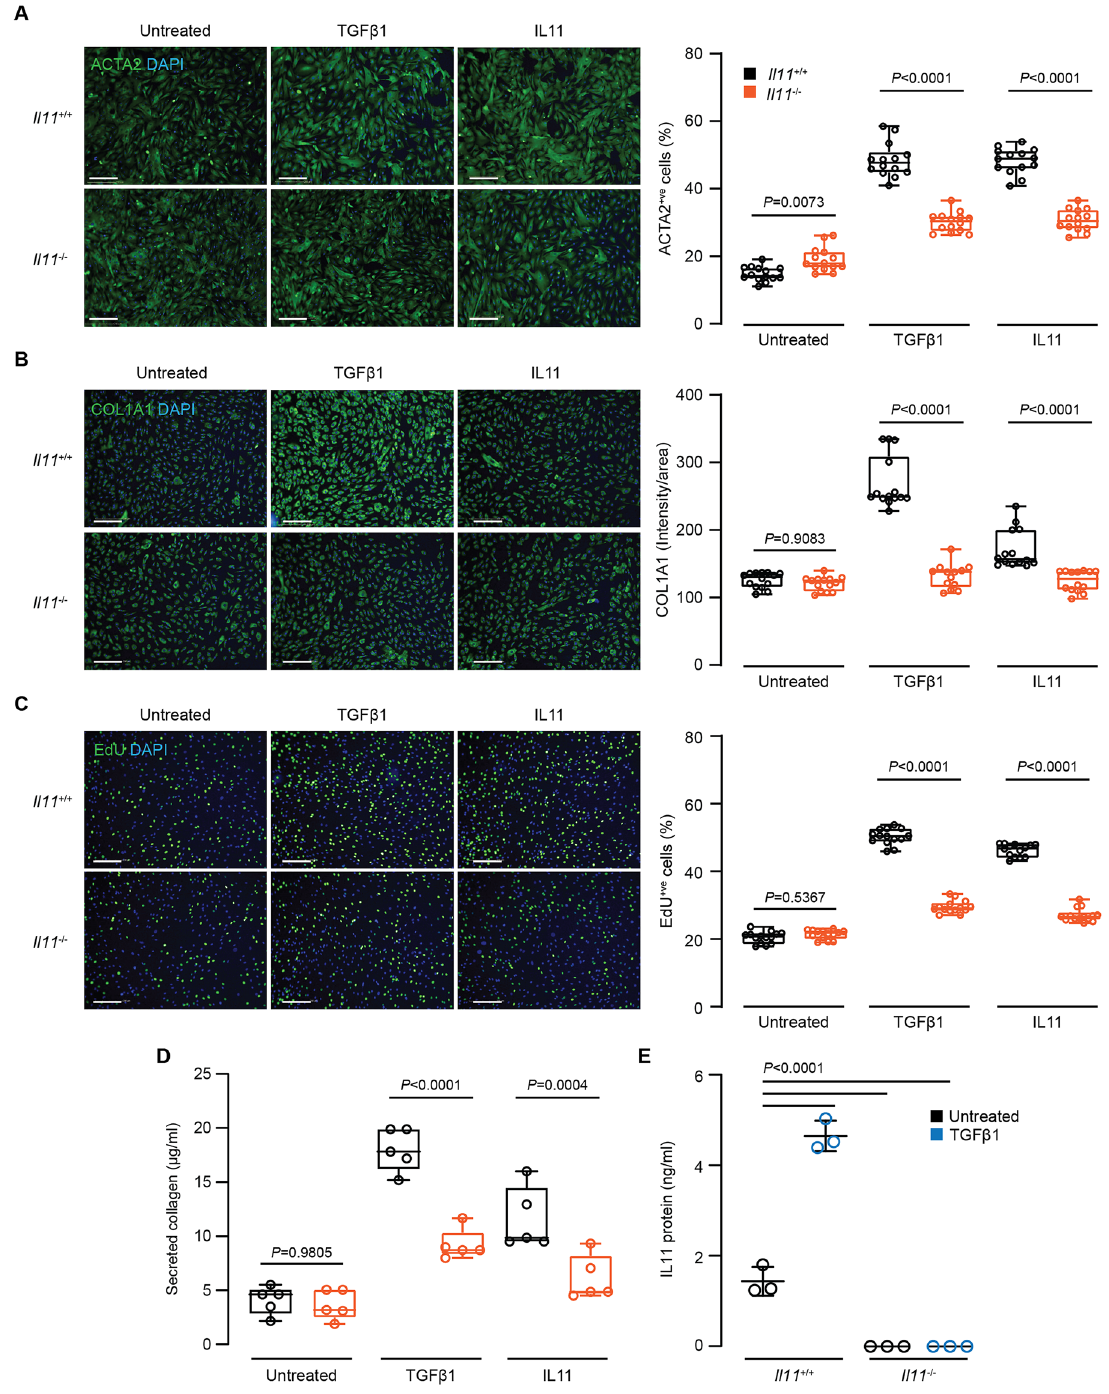
Figure 3. Reduced activation of primary lung fibroblasts from Il11 knockout mice. Automated immunofluorescence quantification of ( A ) ACTA2 +ve cells, ( B ) COL1A1 expression (intensity/area) and ( C ) EdU +ve cells in TGFβ1- or IL11-treated lung fibroblasts from Il11 −/− or wild-type mice (5 ng/ml, 24 h). One representative dataset from two independent biological experiments is shown (14 measurements per condition per experiment). Scale bars: 200 µm. ( D ) Secreted collagen concentrations in supernatant of cells treated as described in ( A , B ) were quantified ( n = 5). ( E ) Secreted IL11 in culture supernatant from TGFβ1-treated lung fibroblasts from Il11 −/− or wild-type mice (5 ng/ml, 24 h; n = 3). Data in ( A – D ) are shown as: centre line, median value; box edges, 25th and 75th percentiles; whiskers, minimum and maximum values; and shown as mean ± SD in ( E ). P values in ( A – D ) were determined by ANOVA (Sidak’s test) and by ANOVA (Tukey’s test) in ( E